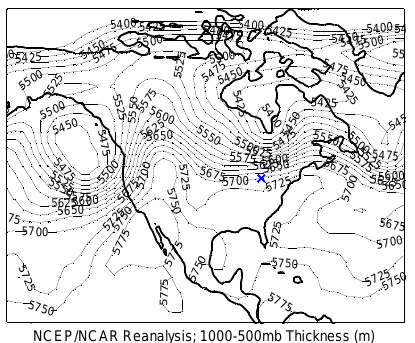
Figure 4: GEM-FLEXPART results showing the 80 ppbv ozone mixing ratio isosurface at 12 UTC on 1st July, 2007. The blue dashed line shows the location of Harrow. Darker colours indicate lower isosurfaces.